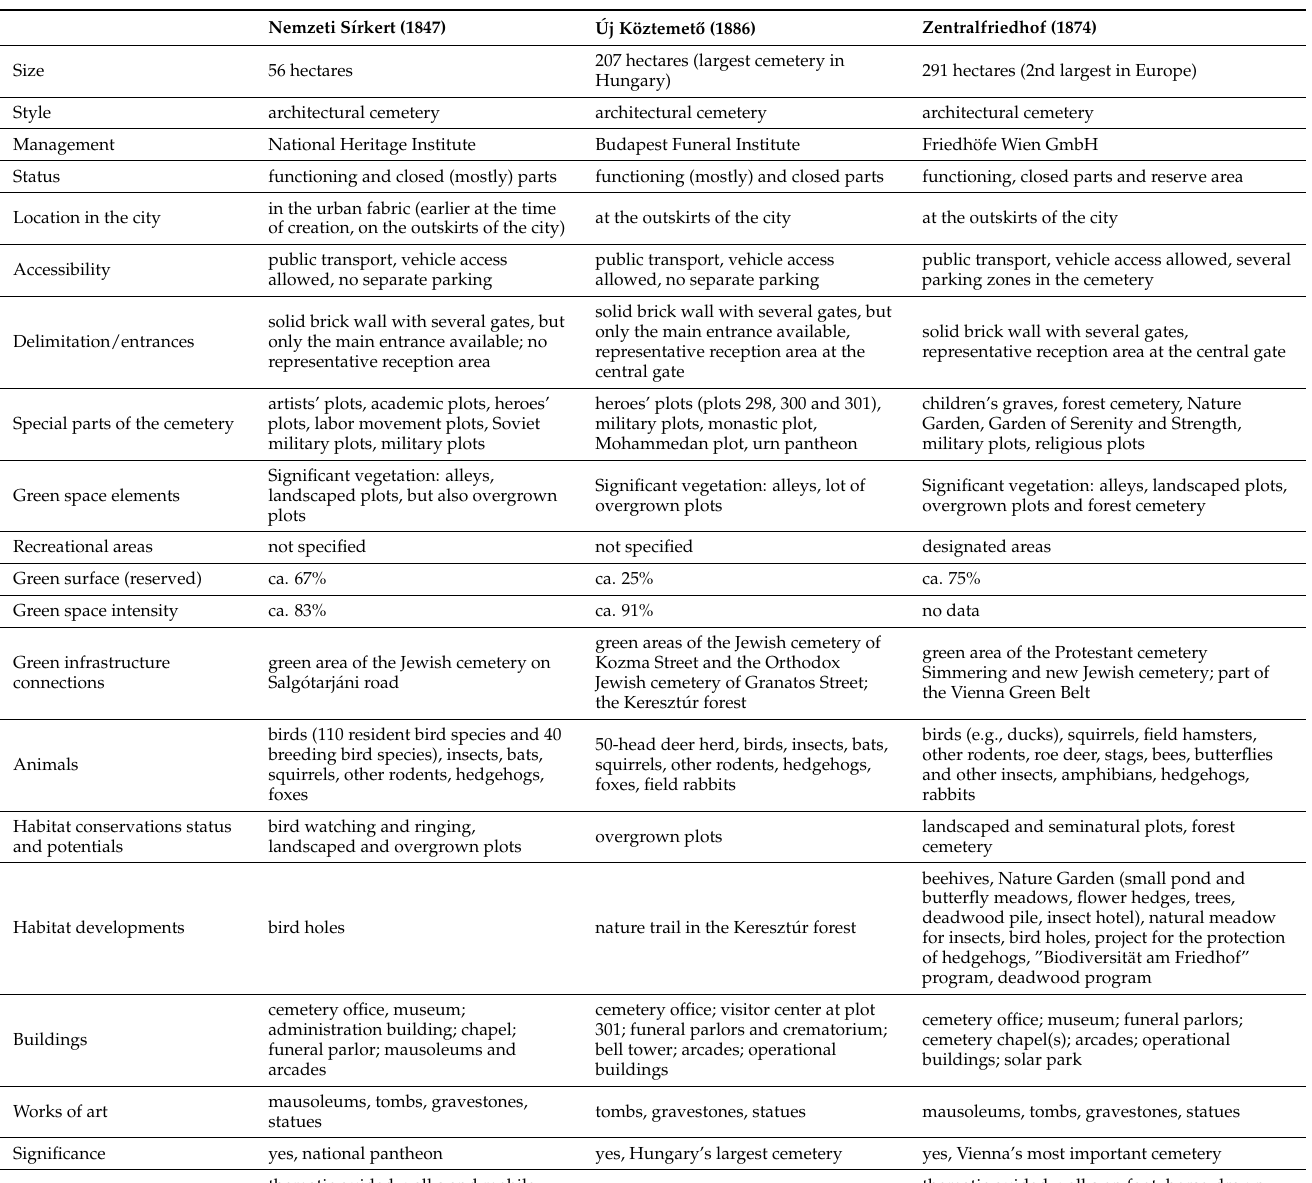
Table 1. Summary of the three sample area cemeteries (authors’